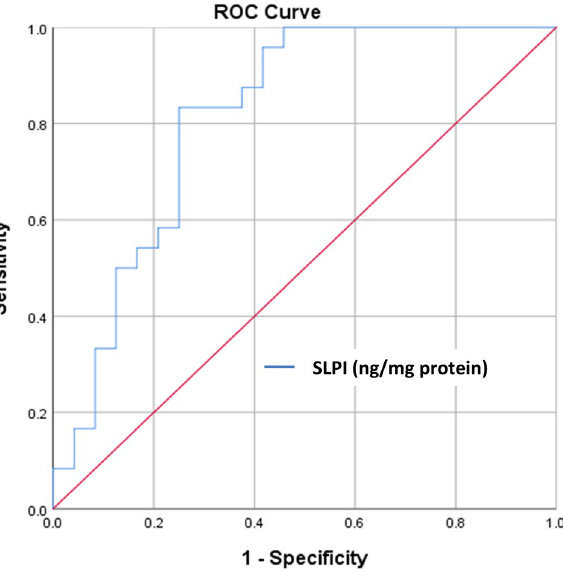
Figure 1. ROC curve for normalized salivary SLPI levels to identify periodontitis versus periodontal health. AUC: 0.81 with 83% sensitivity and 75% specificity (95% CI for the AUC: 0.68–0.93). ROC receiver operating characteristic, SLPI secretory leukocyte protease inhibitor, CI confidence interval, AUC area under the curve, ng nanogram, mg milligram.